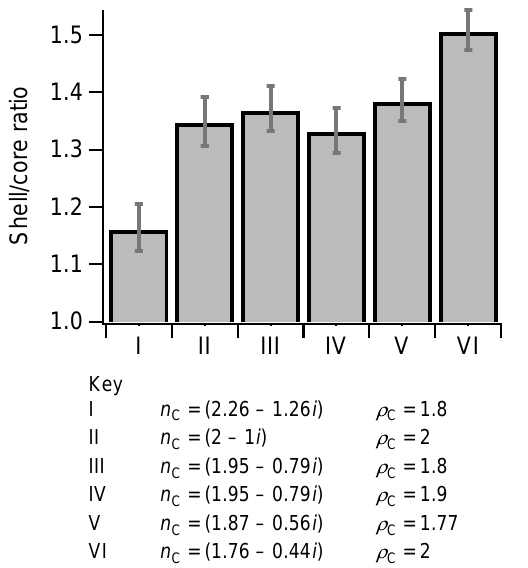
Figure 8. Median shell / core ratio for particles with 135 ≤ D C ≤ 200nm plotted vs. ambient − log ( NO x / NO y ) . Data are plot- ted for the sets of core refractive index and density that result in the thickest and thinnest coatings. Both ambient and thermodenuded (>220 ◦ C) data are shown. The straight lines are linear orthogonal distance regression fits to the data. By definition, the minimum mea- surable shell / core ratio is